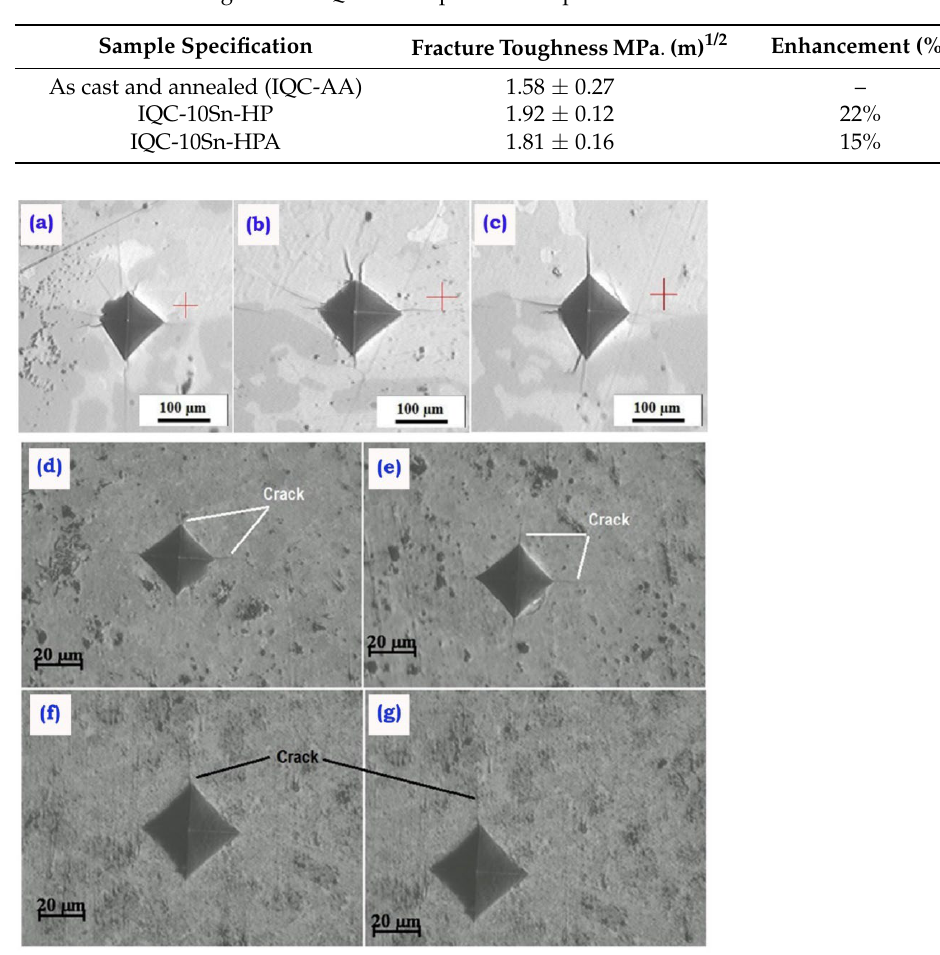
Table 3. Fracture toughness of IQC-Sn hot-pressed composite.